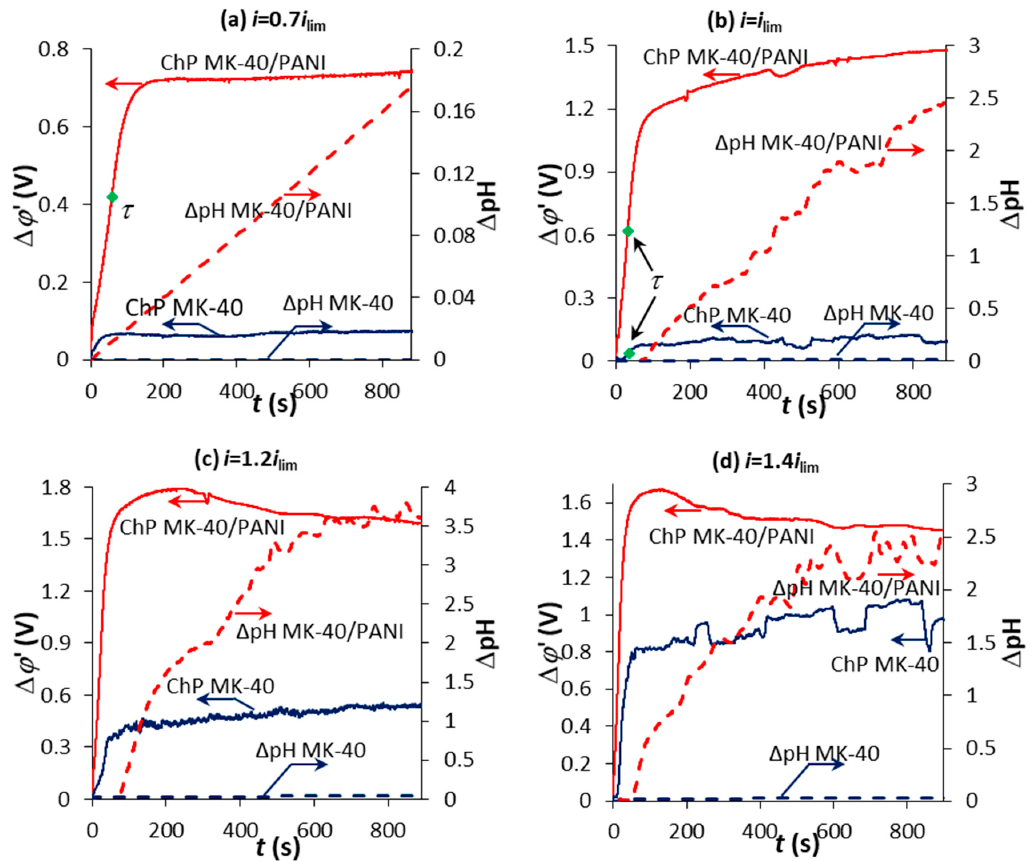
Figure 6. Chronopotentiograms of MK-40 and MK-40/PANI membranes in the model solution and the corresponding time-dependence of the pH of the desalinated solution at i = 0.7 i lim ( a ); i = i lim ( b ); i = 1.2 i lim ( c ); i = 1.4 i lim ( d ).